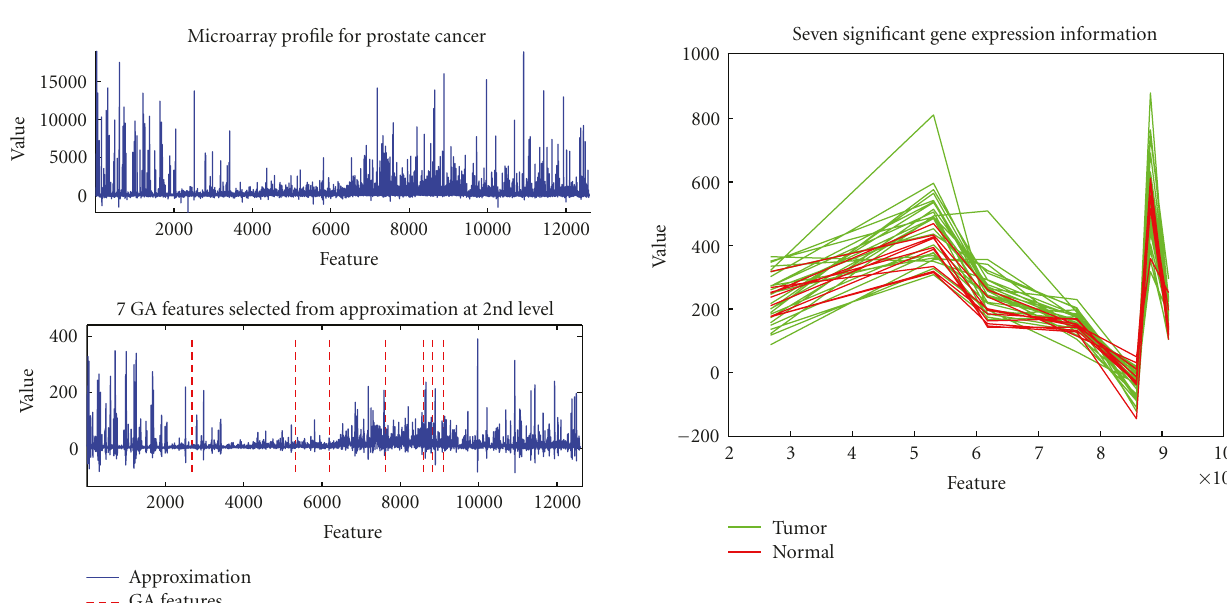
Figure 8: Reconstructed approximation at 2nd level and selected GA features.